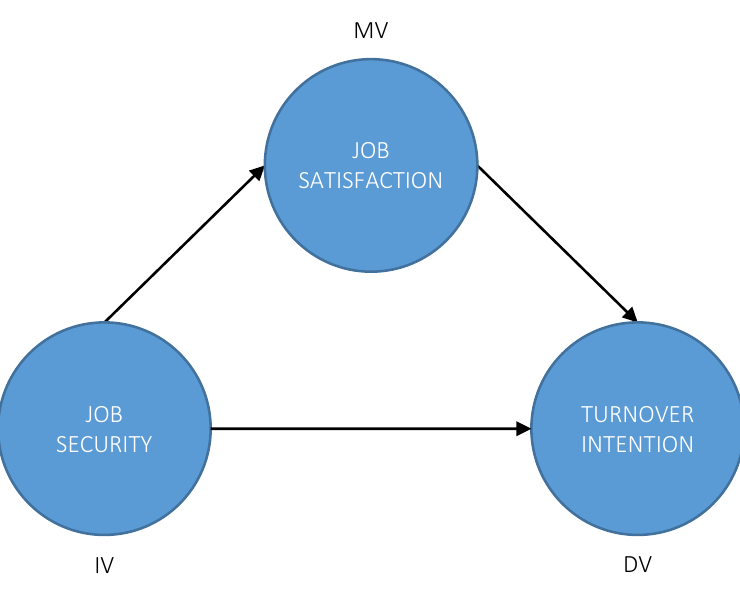
Figure 1. Research